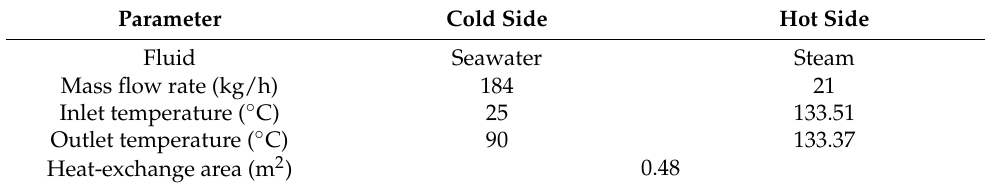
Table 4. Operating parameters for the shell and tube heat exchanger.